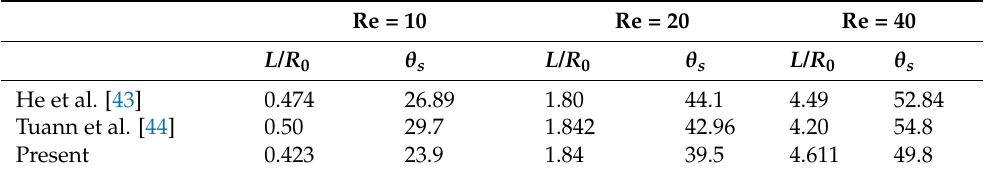
Table 2. Separation angle θ s and wake length L / R 0 of the flow around cylinder at different Reynolds numbers.